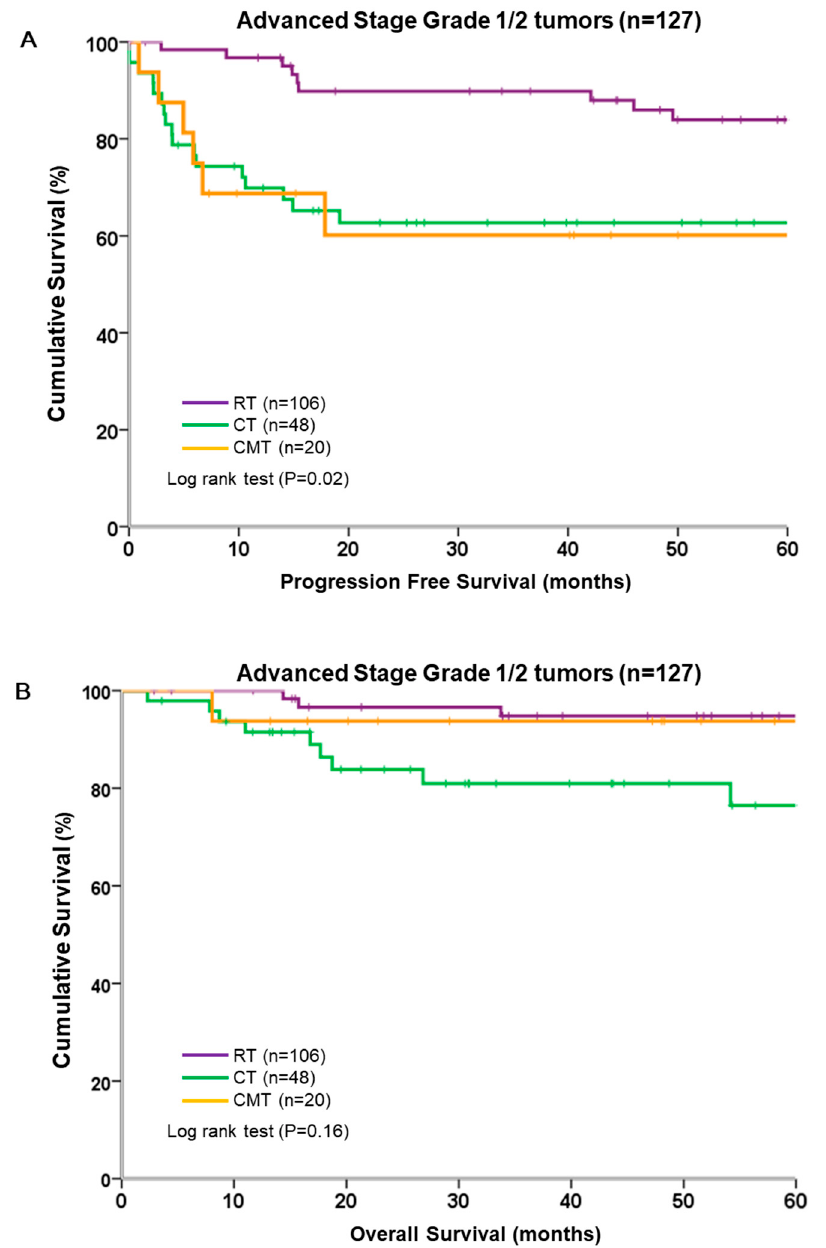
Figure 4. Survival of 127 patients with grade 1/2 tumors, stratified by different adjuvant modalities. ( A ) Progression-free survival; ( B ) overall survival.